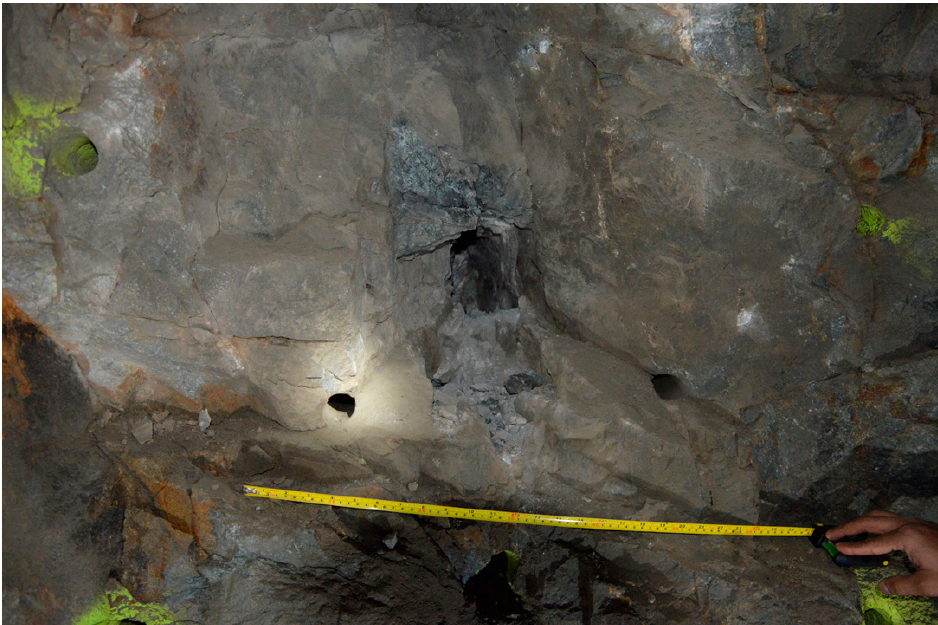
Figure A2. Cavity after detonation of hole with sequence number 1.